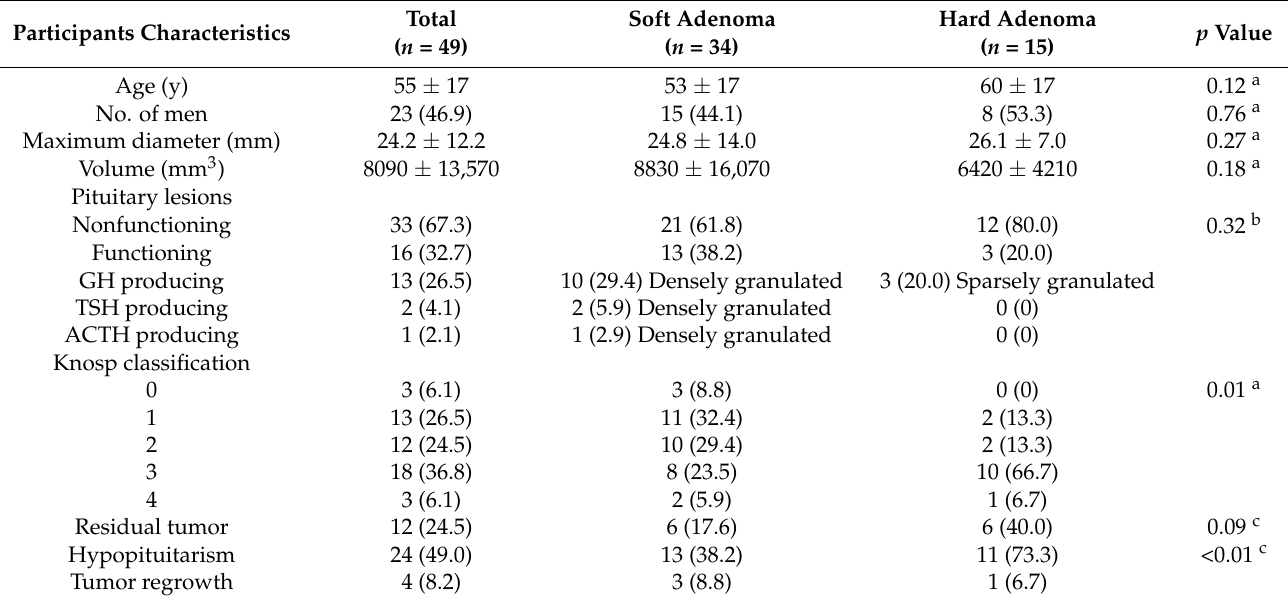
Table 2. Characteristics of participants and